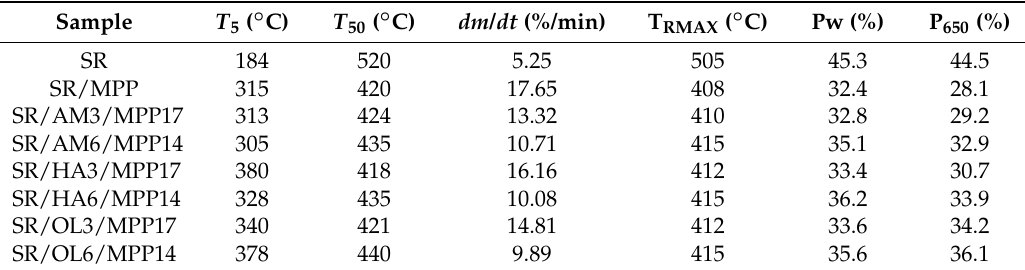
Table 5. Thermal properties of SR/POSS/MPP